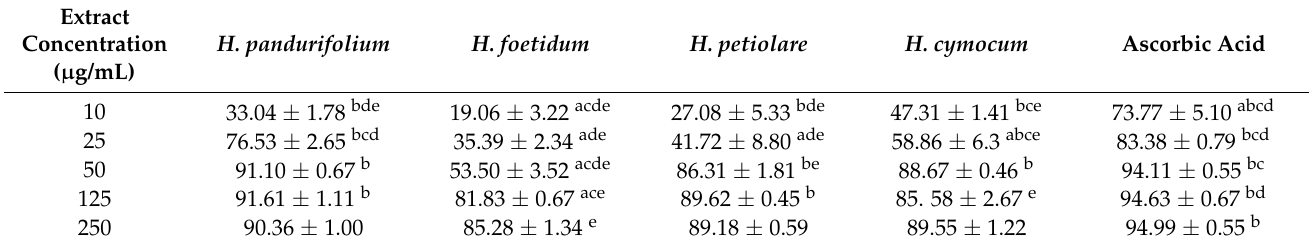
Table 1. DPPH scavenging activity of aqueous acetone extracts of H. pandurifolium, H. foetidum H. petiolare, and H. cymocum .